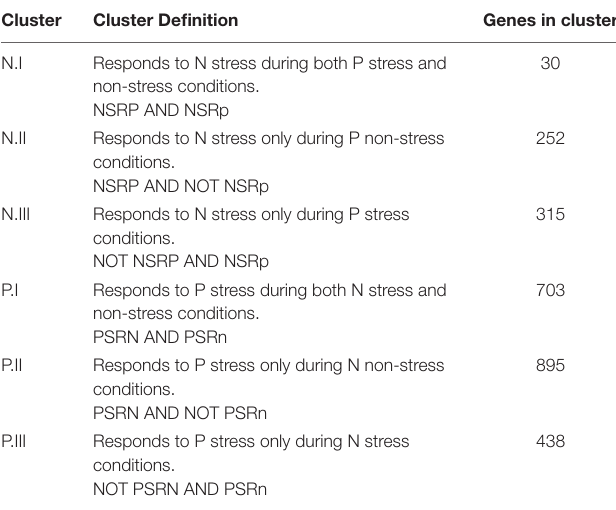
TABLE 2 | Nitrogen and Phosphate gene